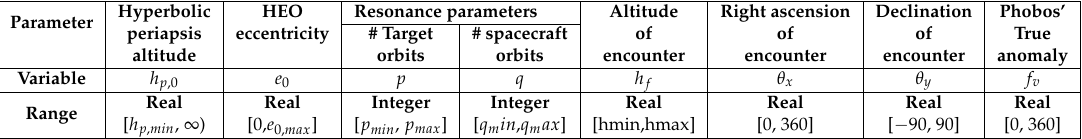
Figure 9. The gene map of the resonant co-orbit design problem describing the different design variables and their